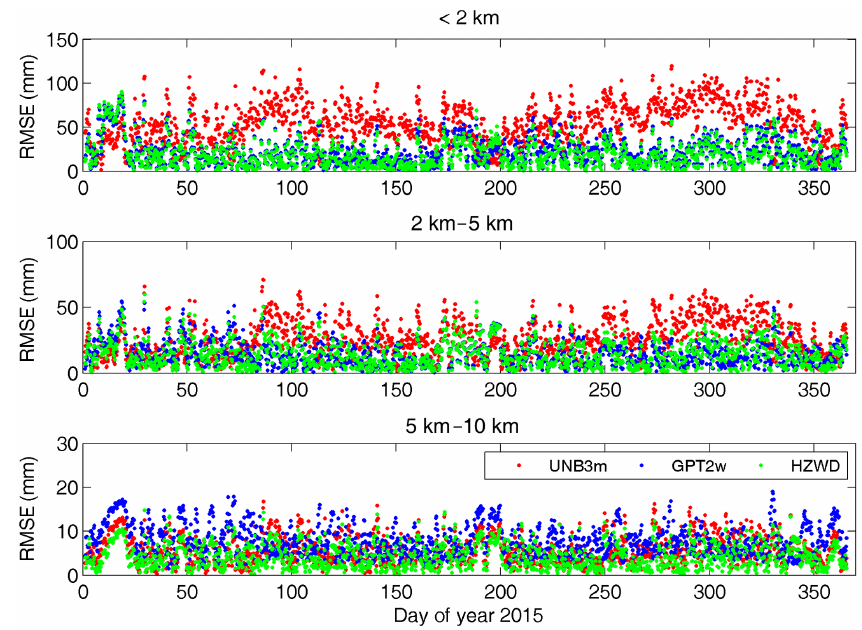
Figure 10. RMSEs in ZWD estimates of the three models (HZWD, GPT2w, and UNB3m) compared to the ECMWF data over the year 2015 at grid point (0 ◦ N, 20 ◦ E).